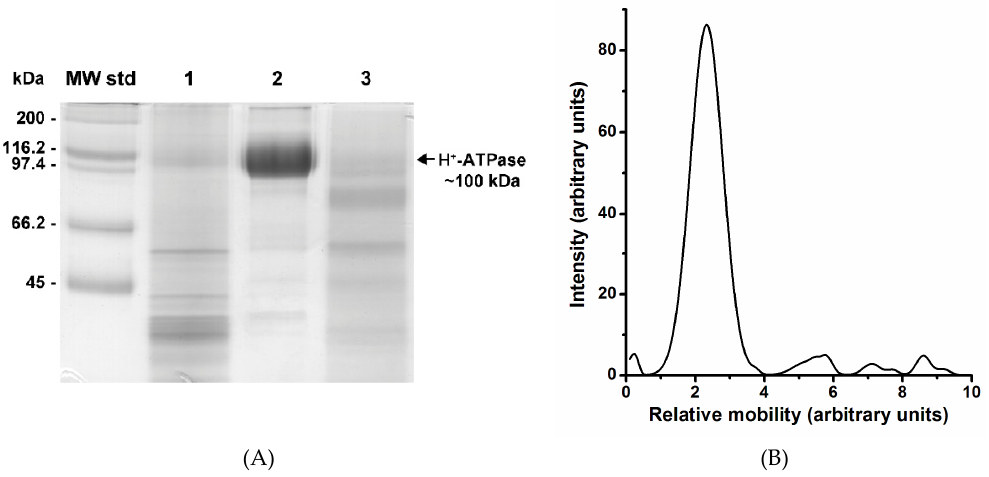
Figure 1. H + -ATPase purified from plasma membranes from K. lactis . Plasma membranes were isolated by differential centrifugation after cell wall enzymic lysis and homogenization. Then, H + -ATPase was purified from plasma membranes as described in the methods section. ( A ) SDS-PAGE of the H + -ATPase purified after ultracentrifugation on a trehalose concentration gradient. Lanes 1, 2, and 3 are protein samples from 30, 45, and 50% trehalose fractions, respectively. Protein bands were visualized by Coomassie blue staining. ( B ) Densitometry analysis of proteins present in lane 2 of the SDS-PAGE gel in A. The percentage of H + -ATPase content was calculated using the ImageJ software (https://imagej.nih.gov/ij/). The plasma membrane H + -ATPase, the main peak corresponding to a molecular weight of ~100 kDa, was the most abundant protein (~90%).